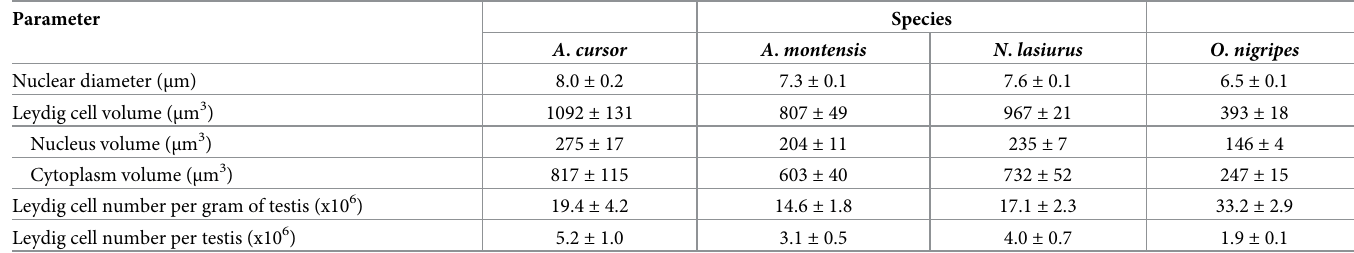
Table 5. Leydig cell morphometric parameters in A . cursor , A . montensis , N . lasiurus and O . nigripes (mean ±